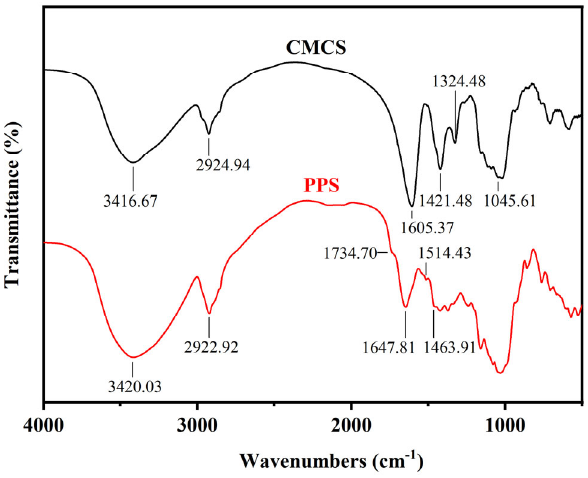
Figure 3. FT–IR spectrograms of PPS and